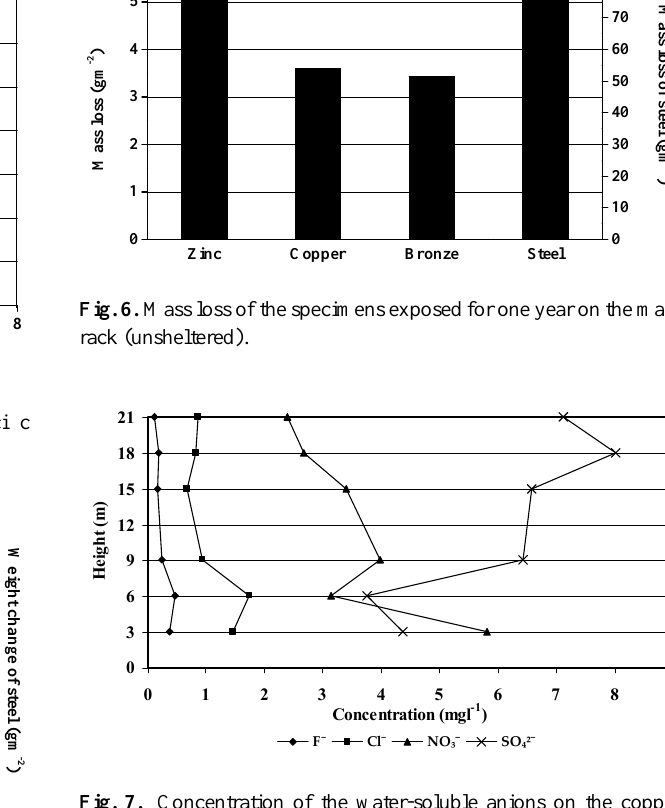
Fig. 7. Concentration of the water-soluble anions on the copper specimens exposed for one year as a function of